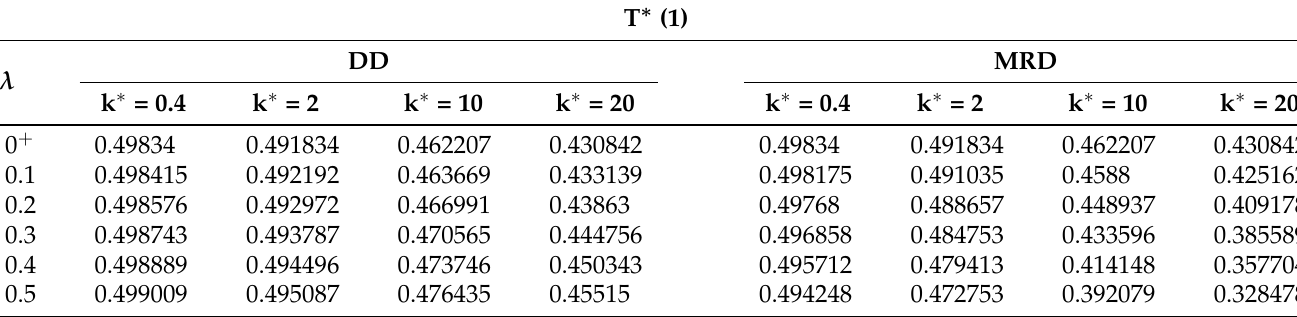
Figure 9. SS − q beam. Comparison of the DD and MRD methods for increasing values of the (cid:8) (cid:9) non-dimensional non-local parameter λ in the set 0 + ,0.1,0.2,0.3,0.4,0.5 with k ∗ = { 0.4,2,10 } : ( c ) non-dimensional bending moment M ∗ ( 1/2 ) , and ( d ) non-dimensional shear force T ∗ ( 1 ) . Table 9. Simply supported beam subjected to a non-dimensional uniform load q ∗ y = − 1. Non-dimensional shear force T ∗ ( 1 ) versus the non-dimensional length-scale parameter λ evaluated by the non-dimensional Winkler parameter k ∗ ∈ { 0.4,2,10,20 } in the DD and MRD models.